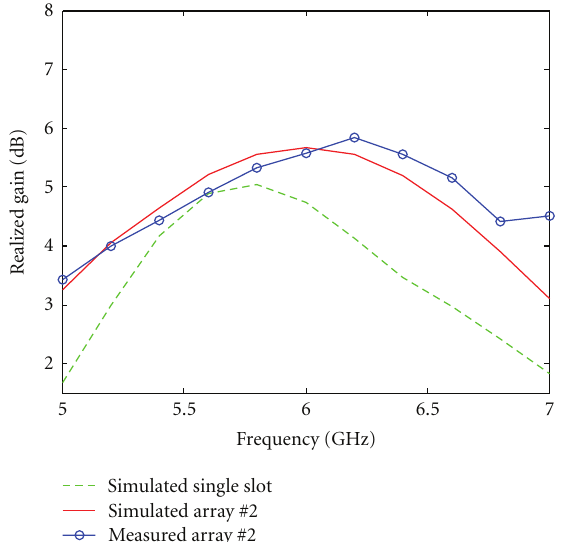
Figure 10: Simulated and measured gain results of single-slot and four-slot array no. 4 ( d = 14